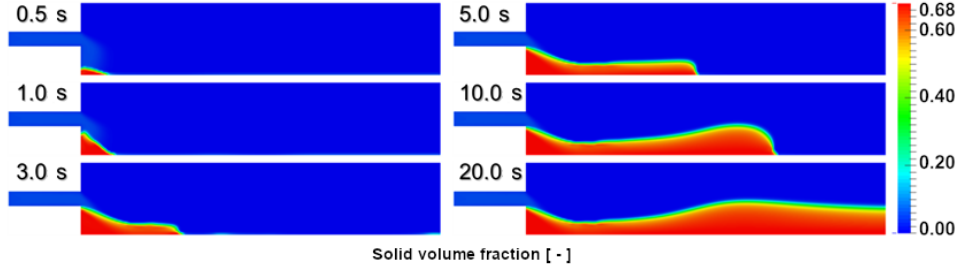
Figure 3. The velocity fields at different time steps with considering the gravity and using the proposed particle flux model.